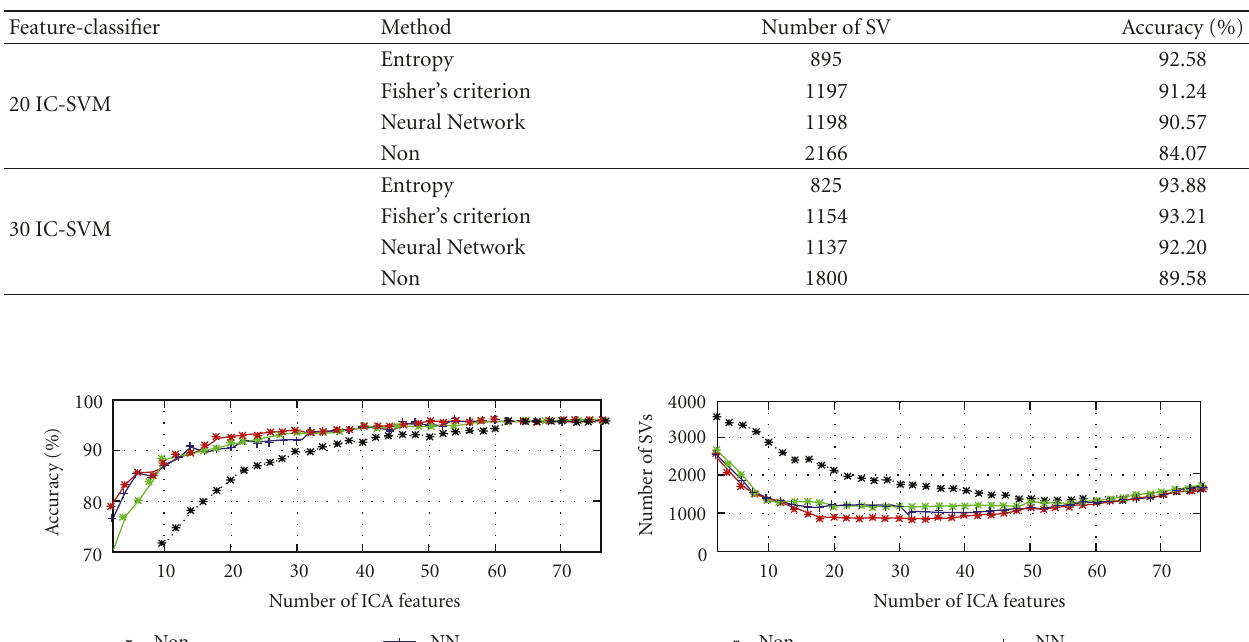
Table 1: Results for feature selection and classification.